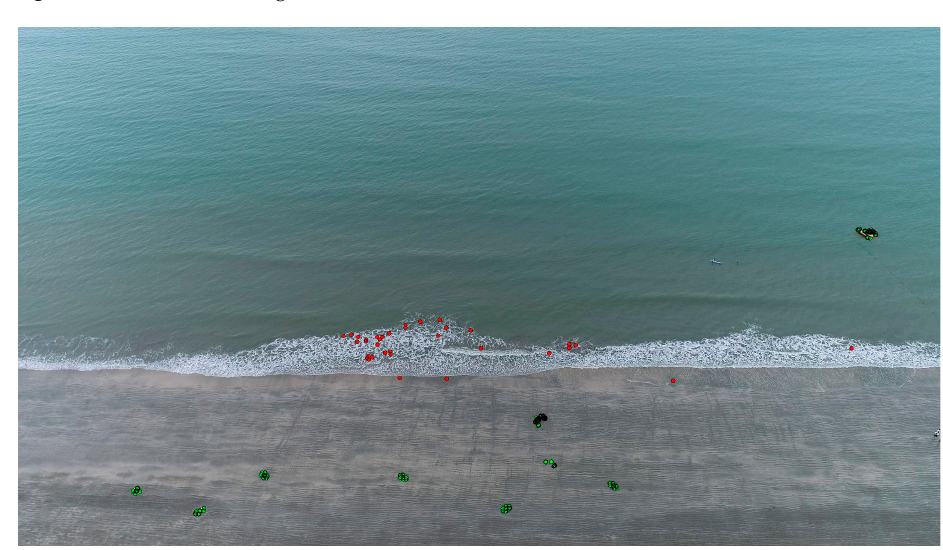
J. Mar. Sci. Eng. 2023 , 11 , x FOR PEER REVIEW Figure 6. Camera Euler angles. Figure 6. Camera Euler angles.